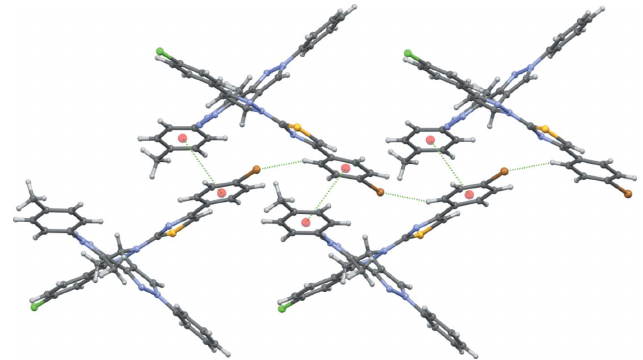
Figure 2 Part of the crystal structure showing intermolecular interactions as dotted lines.